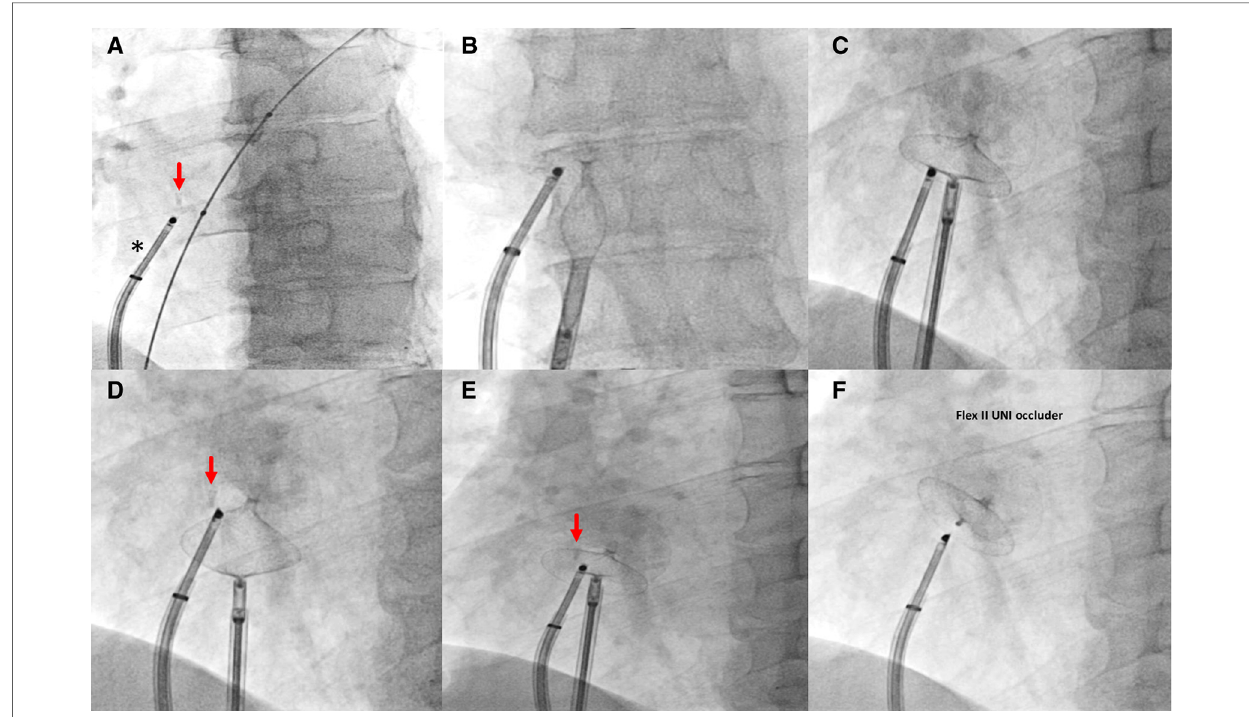
FIGURE 3 Fluoroscopic steps of implantation of Flex II UNI occluder (Occlutech GmbH, Jena, Germany) with equally sized discs (28.5 mm×28.5 mm) under rotational intracardiac echo by Ultra ICE (black asterisk). ( A – C ) left and right disc opening; ( D,E ) pull and push maneuver to test device stability; ( F ) device deployed. Red arrow, radiopaque polypropylene knot.